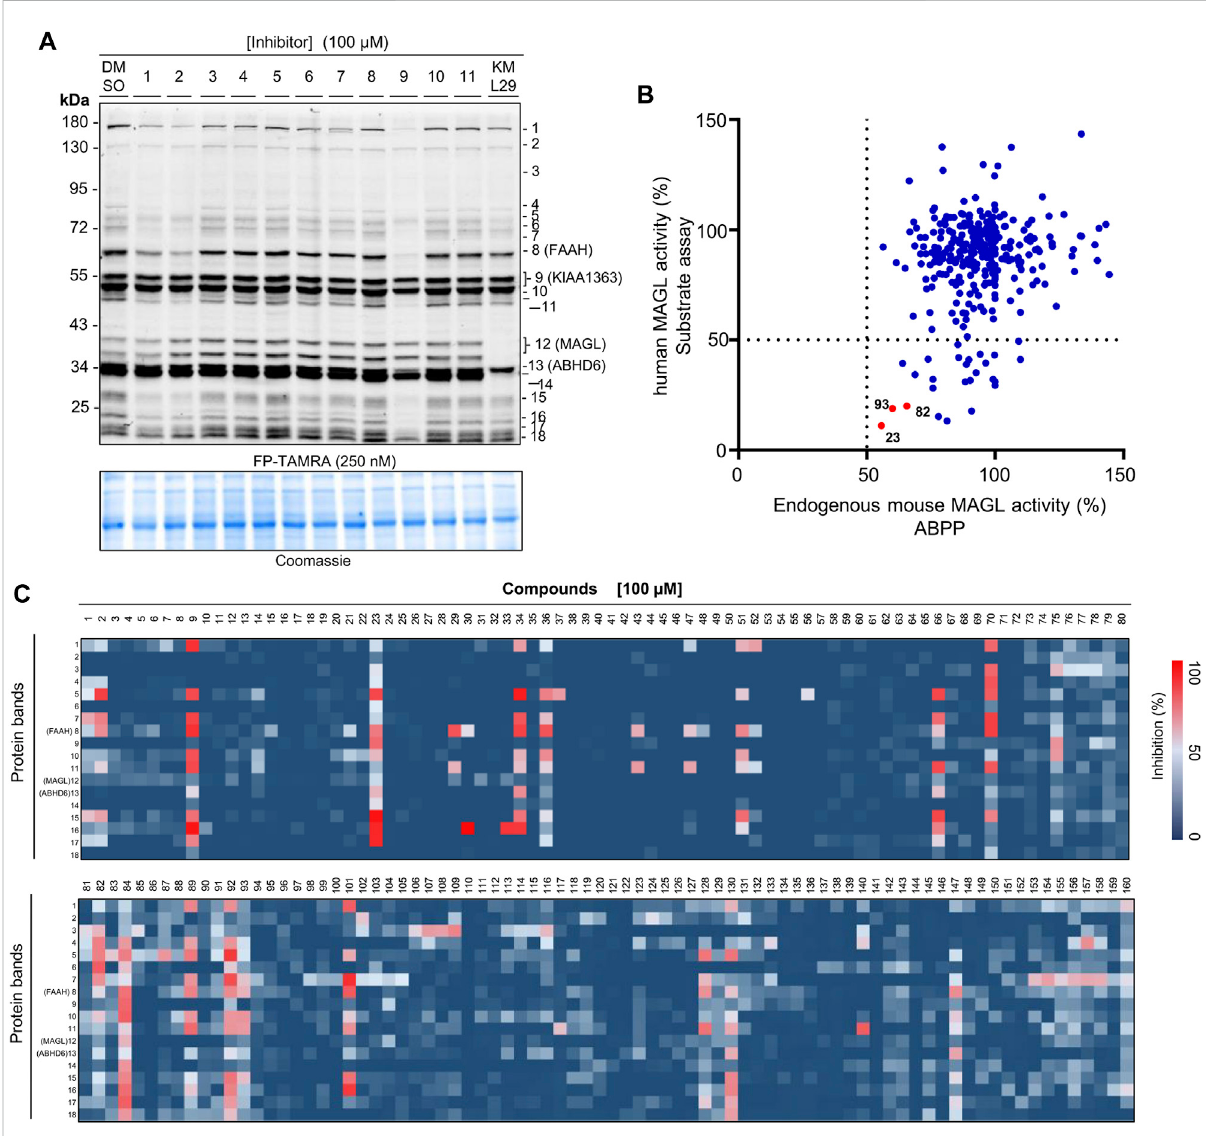
FIGURE 4 Activityandselectivitypro fi leofthefocusedcompoundlibraryusingABPP. (A) RepresentativegelofABPPassayfordeterminationoftheactivity and selectivity of compounds 1 - 11 . A known MAGL inhibitor KML29 (10 µM) was used as a control compound. Coomassie staining gel was used as a loading control. (B) Analysis of the ABPP assay vs. AA-HNA assay against MAGL (100 µM compounds). (C) Heatmap overview of the screen of compound selectivity. The inhibition of each protein band was quanti fi ed from competitive ABPP gels (e.g., Figure 4A and Supplementary FiguresS7, S8).Notethat thepercentagevalues werenormalizedtotheintensity